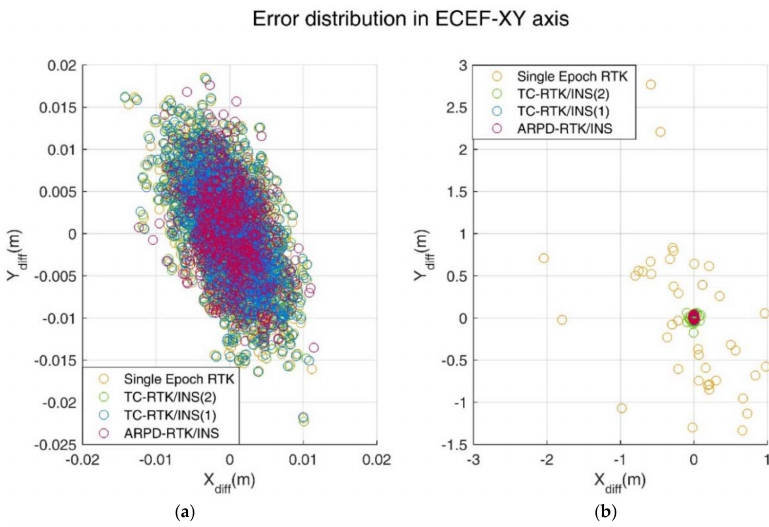
Figure 8. ( a ) Error distribution in Earth-Centered Earth-Fixed (ECEF)-XY axis under Scene A; ( b ) Error distribution in ECEF-XY axis under Scene